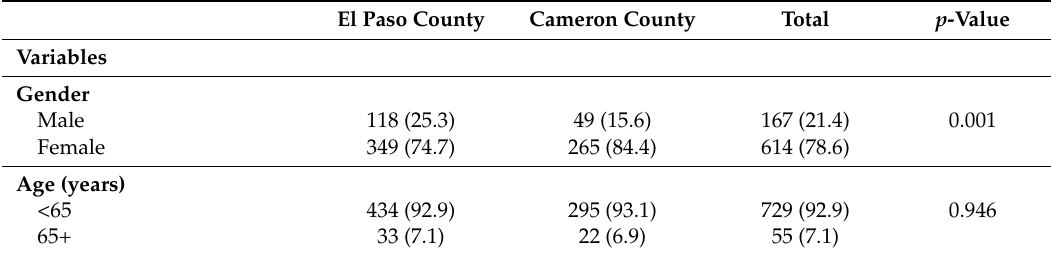
Table 1. Demographic characteristics and physical activity levels in the Against Colorectal Cancer in Our Neighborhoods (ACCION) sample by county of